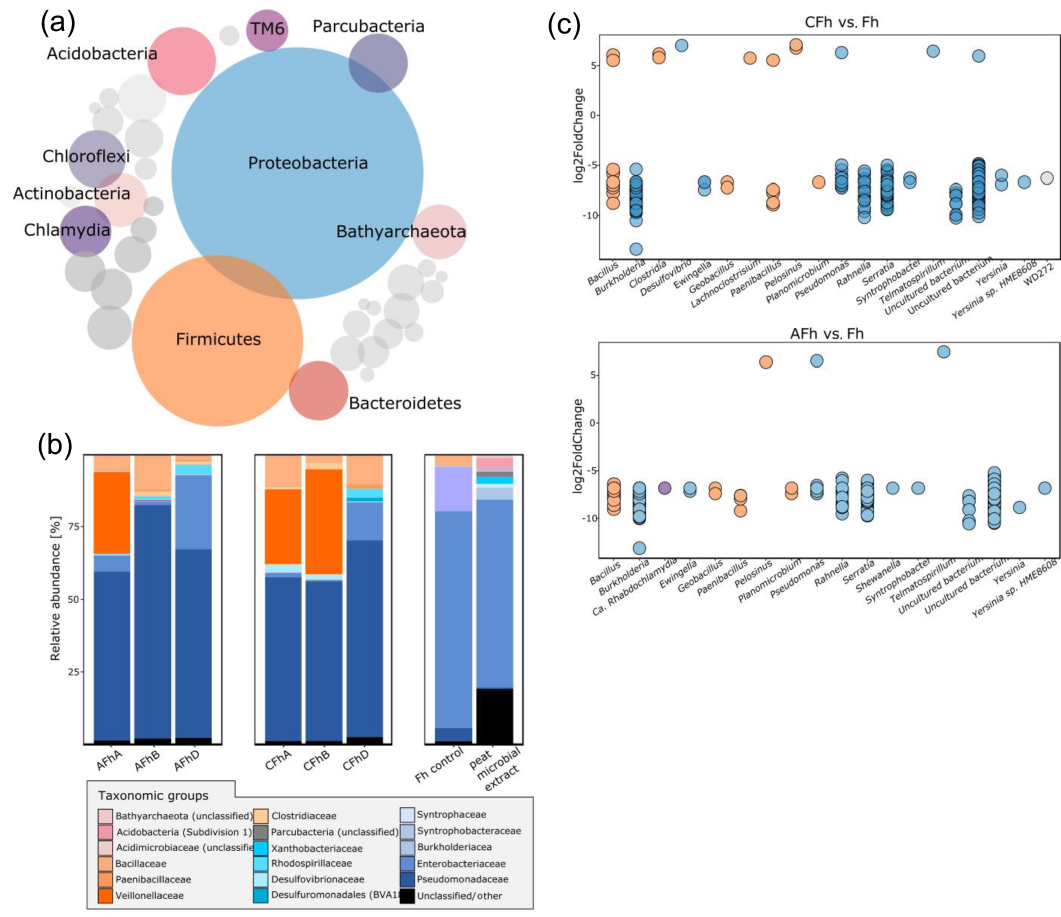
Figure 3. Microbial community profiling from incubations with coprecipitated OM–ferrihydrite (CFh) or adsorbed OM–ferrihydrite (AFh) compared to microbial communities with pure ferrihydrite (Fh control) at the end of incubation and microbial consortia extracted from peatland at beginning of incubation (peatland microbial extract). Bubble plot indicating the relative abundance of prokaryotic phyla when individual data sets are pooled (a) . Bubbles are sized according to respective relative abundances. The 10 most abundant phyla are highlighted by color. Grey bubbles refer to less abundant phyla. Family-level taxonomic profiles are given for individual data sets. Family-level groups showing abundances less than 1%, and unclassified OTUs are summarized as “Unclassified/Other” (b) . Differentially abundant genus- level groups in sample-wise comparisons were identified assuming negative binomial distributions for read count data and applying Wald significance tests, and parametric fitting for determined dispersions. Tests were carried out using ferrihydrite complexation as decisive parameter. Multiple inference correction was done according to Benjamini-Hochberg (1995). Values of p less than 0.05 were considered significant (c) . The color scheme in panels (b) and (c) is according to panel (a) . Family-level groups belonging to the Firmicutes are for instance shown in shades of orange in the case of panel (b) . In panel (b) , AFhA-C refers to increasing TOC concentrations (44, 105, 181mgg − 1 C) in adsorbed OM–ferrihydrite incubations and CFhA-C refers to increasing TOC concentrations (TOC: 44, 98, 182mgg − 1 C) in incubations with coprecipitated